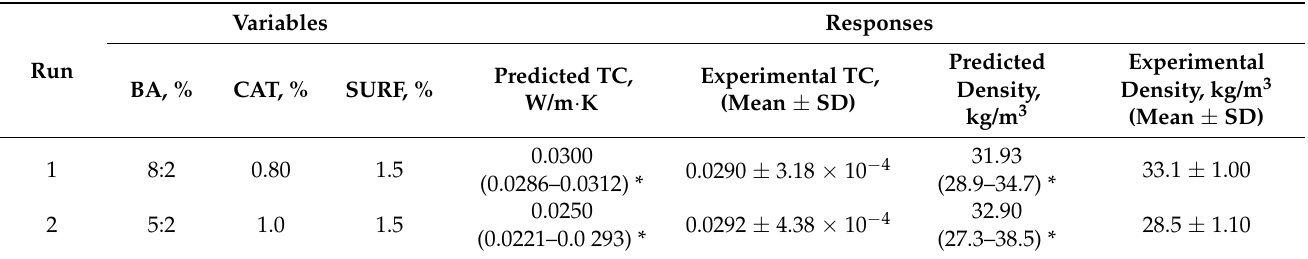
Table 5. Validation of the fitted model for I OH and viscosity.